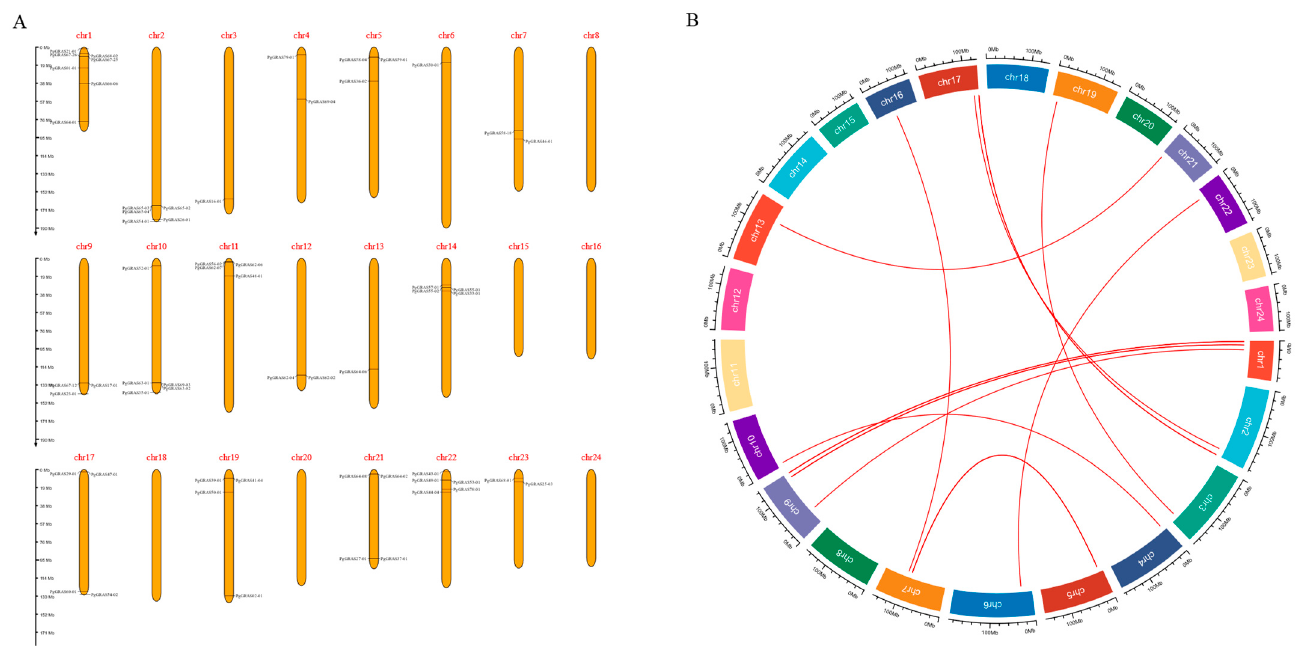
Figure 1. Chromosomal localization and synteny block of the PgGRAS gene family in Panax ginseng . ( A ) Chromosomal localization of the GRAS gene family in Panax ginseng . ( B ) Synteny block of PgGRAS gene family members within the ginseng genome. Red arcs indicate synteny between genes, Chr: Chromosome, extrachromosomal scale represents the length of chromosome (Mb).